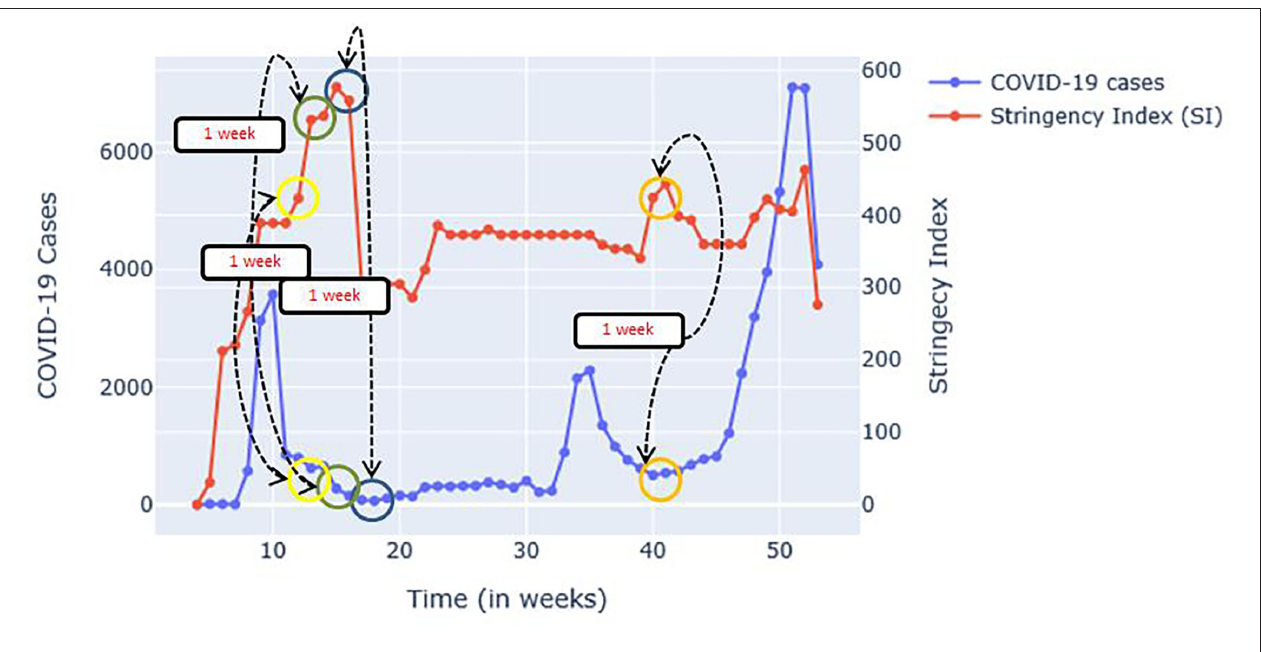
FIGURE 4 | The plot of SI and COVID-19 cases.